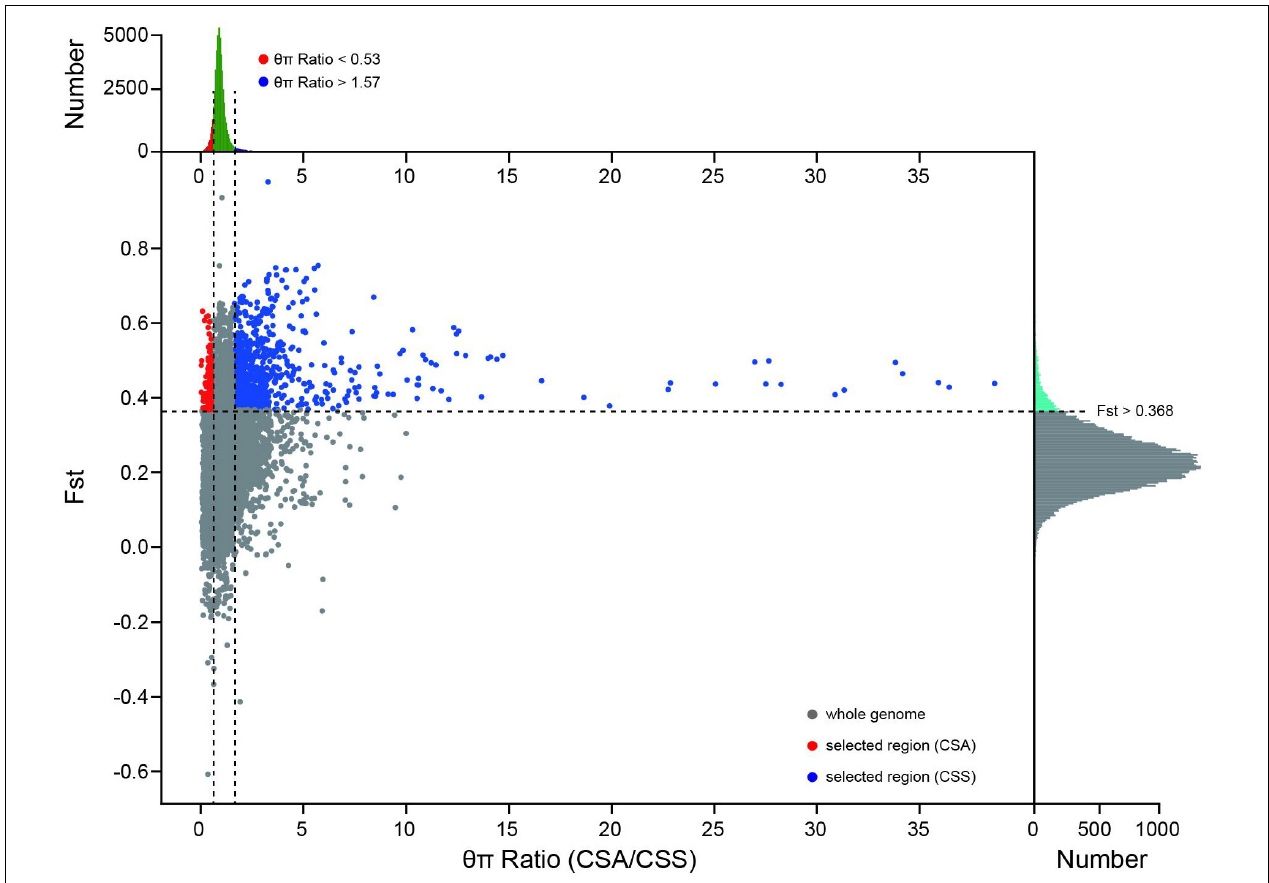
FIGURE 5 | Fst and θπ based selective sweep identification between CSS and CSA population. The red dots and blue dots indicate the selected regions of the CSA and CSS subgroups on the genome, respectively. The subplot on the top reflects the distribution of θπ Ratio, and the subplot on the right reflects the distribution of Fst.